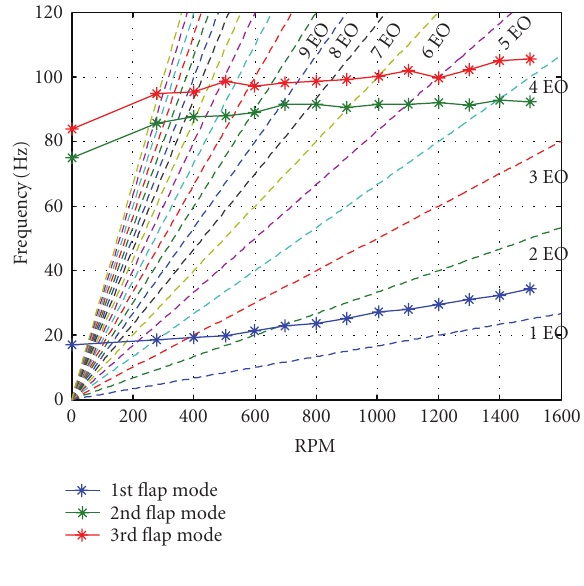
Figure 4: BTT rig fan Campbell diagram.